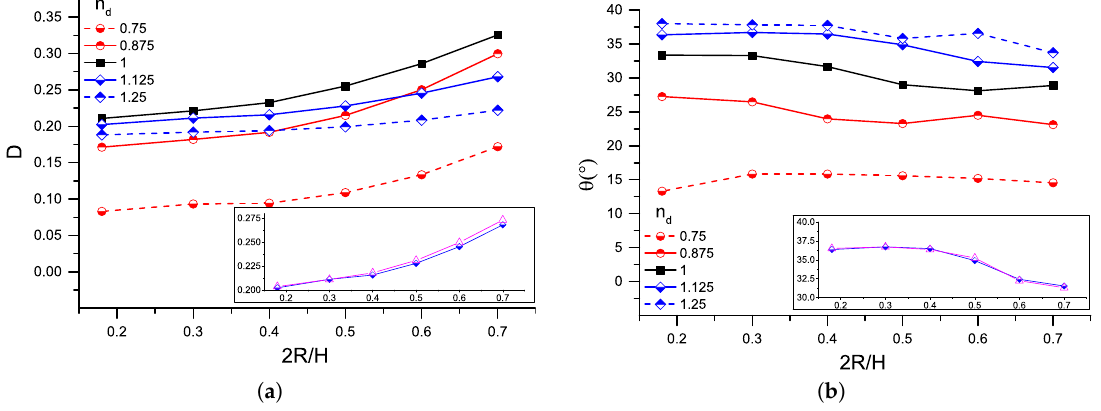
Figure 7. ( a ) droplet deformation and ( b ) orientation angle as a function of the confinement ratio, 2 R / H , for various power–law exponents, n d , at Ca = 0.2. Insets: comparison of droplet characteristics for nd = 1.125 and the Newtonian droplet of λ = 0.3